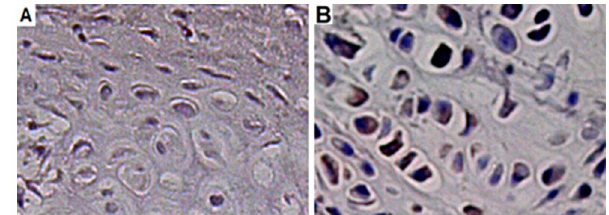
Figure 4. Immunohistochemistry of vascular endothelial growth factor (VEGF) expression within the callus of a control animal (A) and a telmisartan-treated (B) at 2 weeks post-